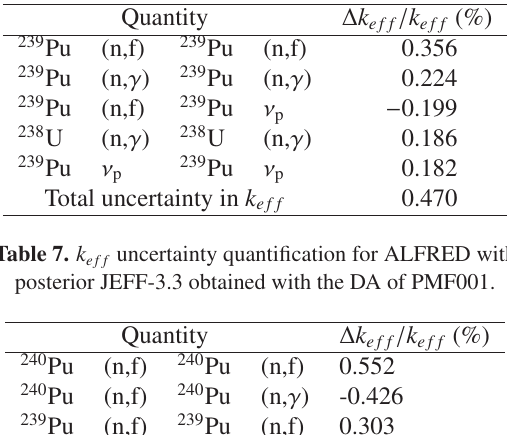
Table 6. k ef f uncertainty quantification for ALFRED with posterior ENDF / B-VIII.0 obtained with the DA of PMF001.